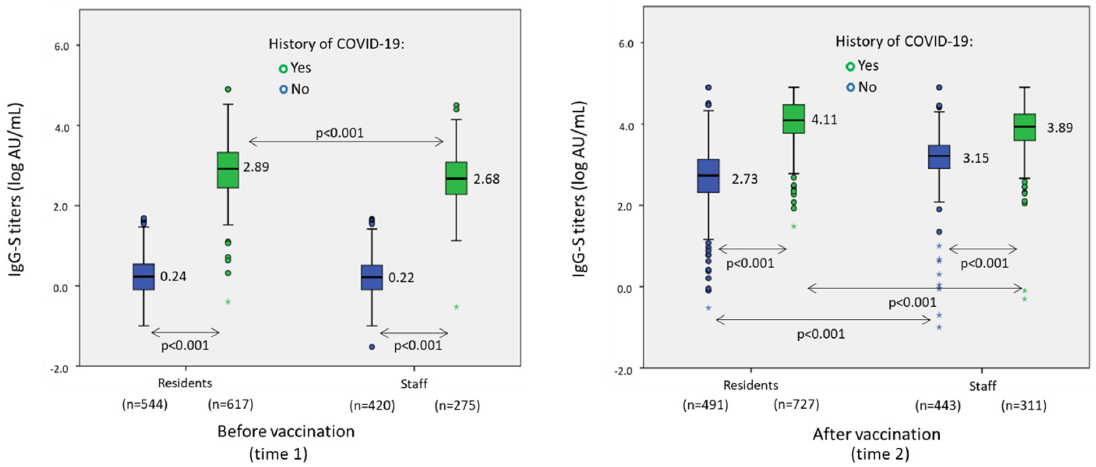
Figure 1. Association between IgG and spike titers before and after BNT162b2 mRNA-SARS-CoV-2 vaccination and history of COVID-19 (as defined by positive IgG-N and/or IgG-S), in residents and staff in nursing homes.